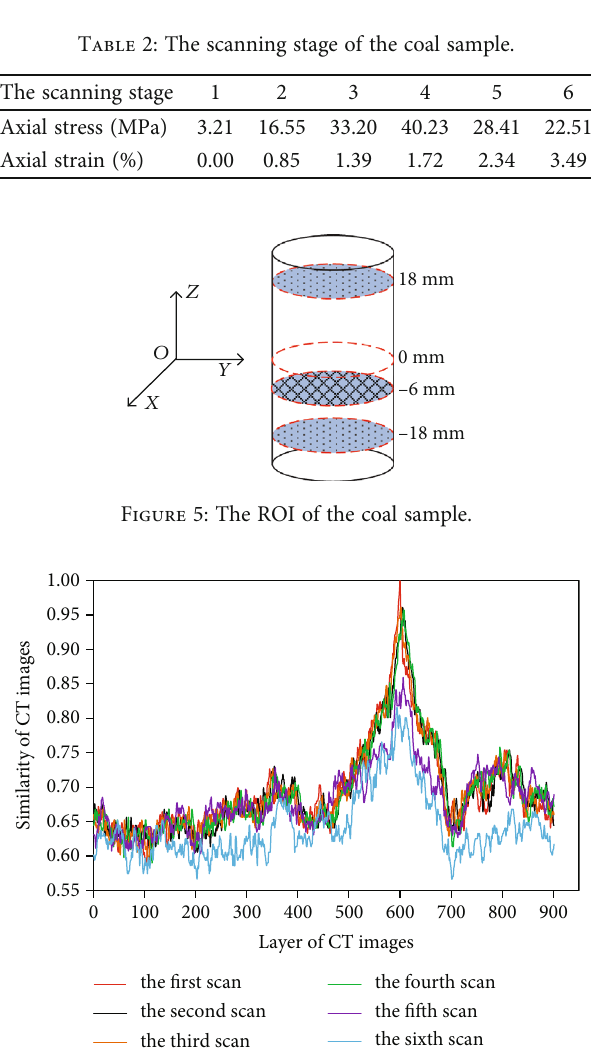
Figure 6: Similarity between the target and sample images in each scanning